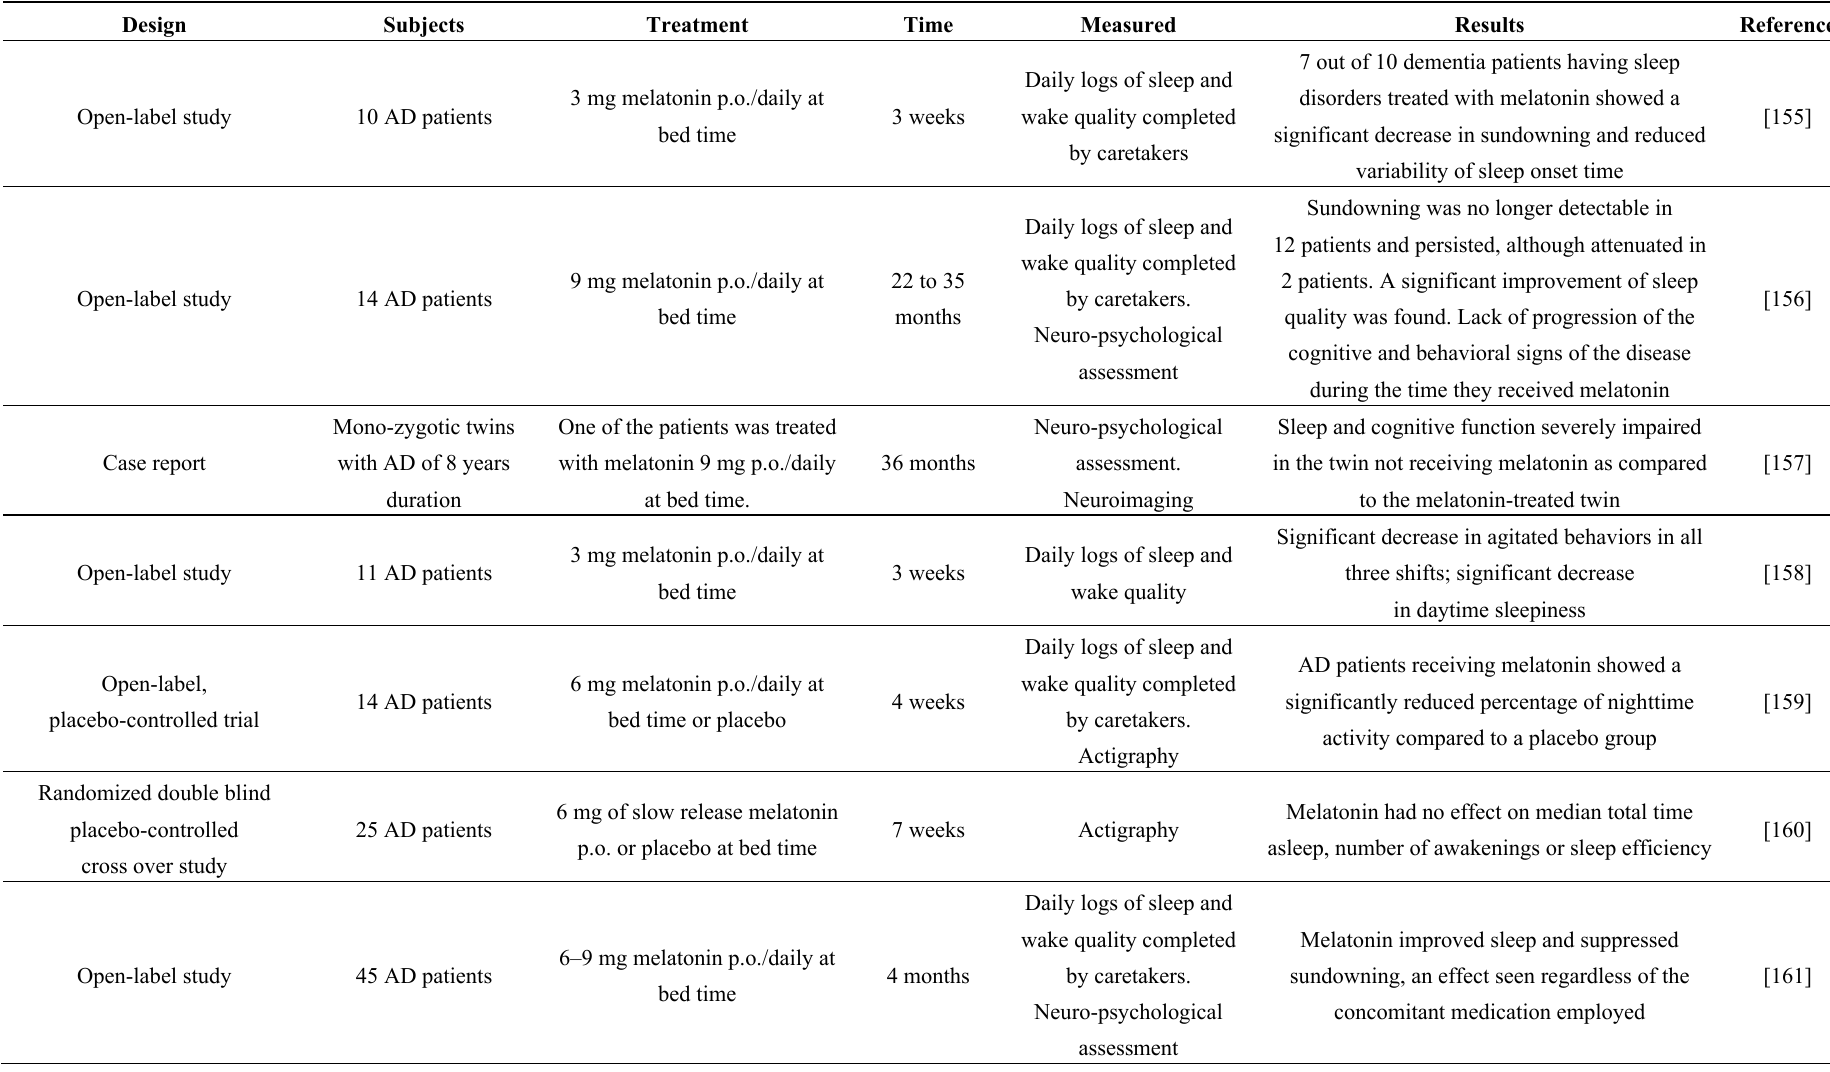
Table 1. Studies including treatment of Alzheimer’s disease (AD) patients with